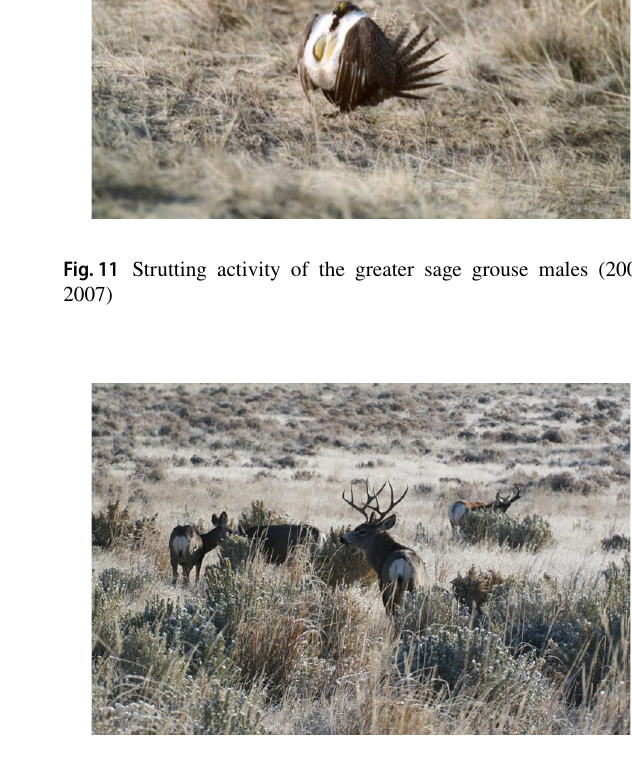
Fig. 12 Mule deer and pronghorn on reclaimed lands